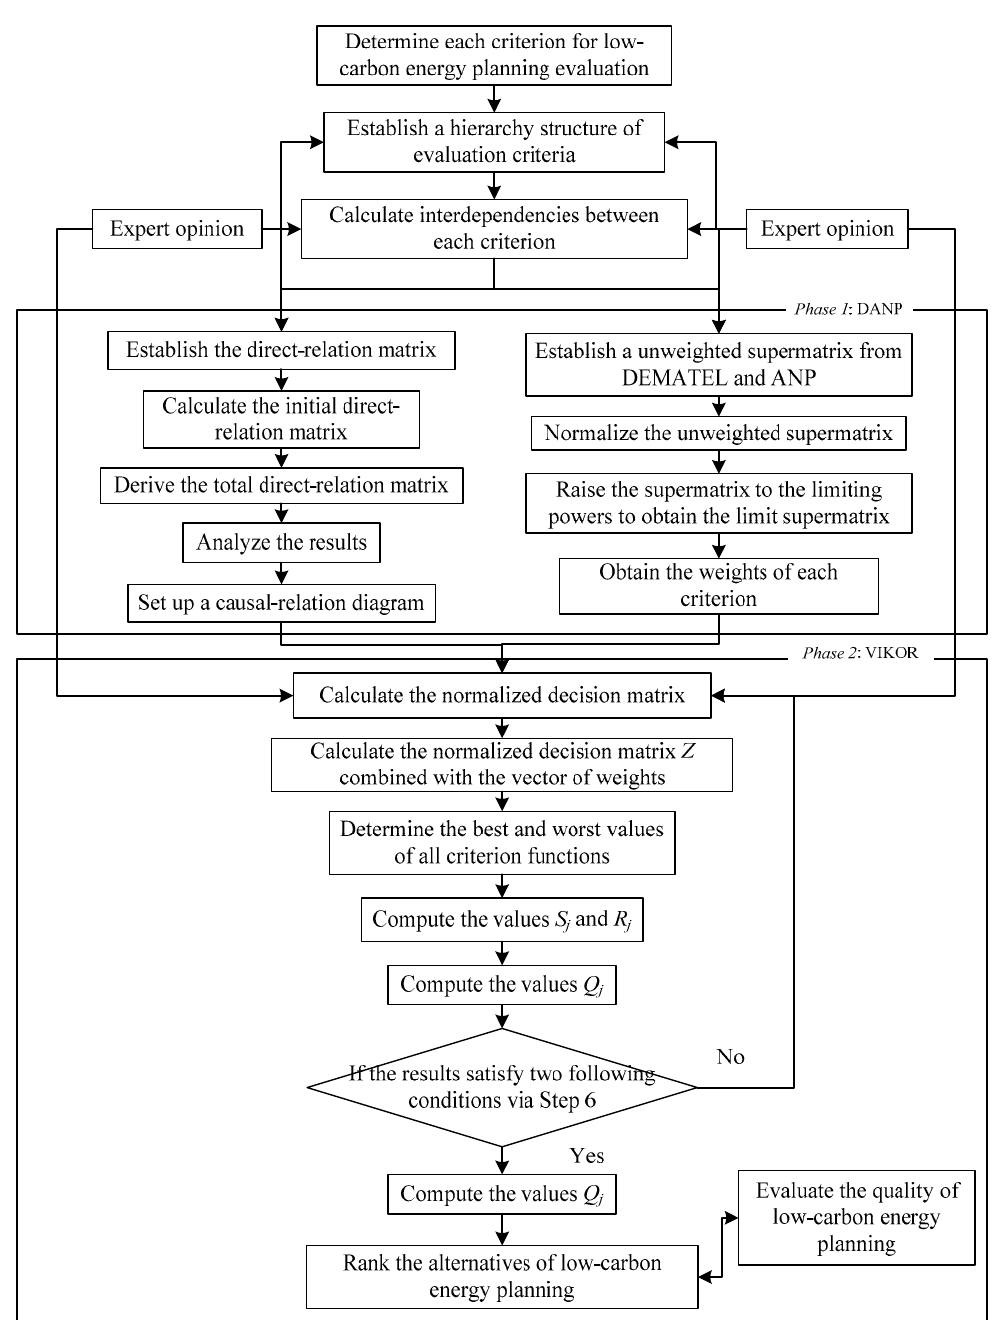
Figure 2. Methodology flowchart.